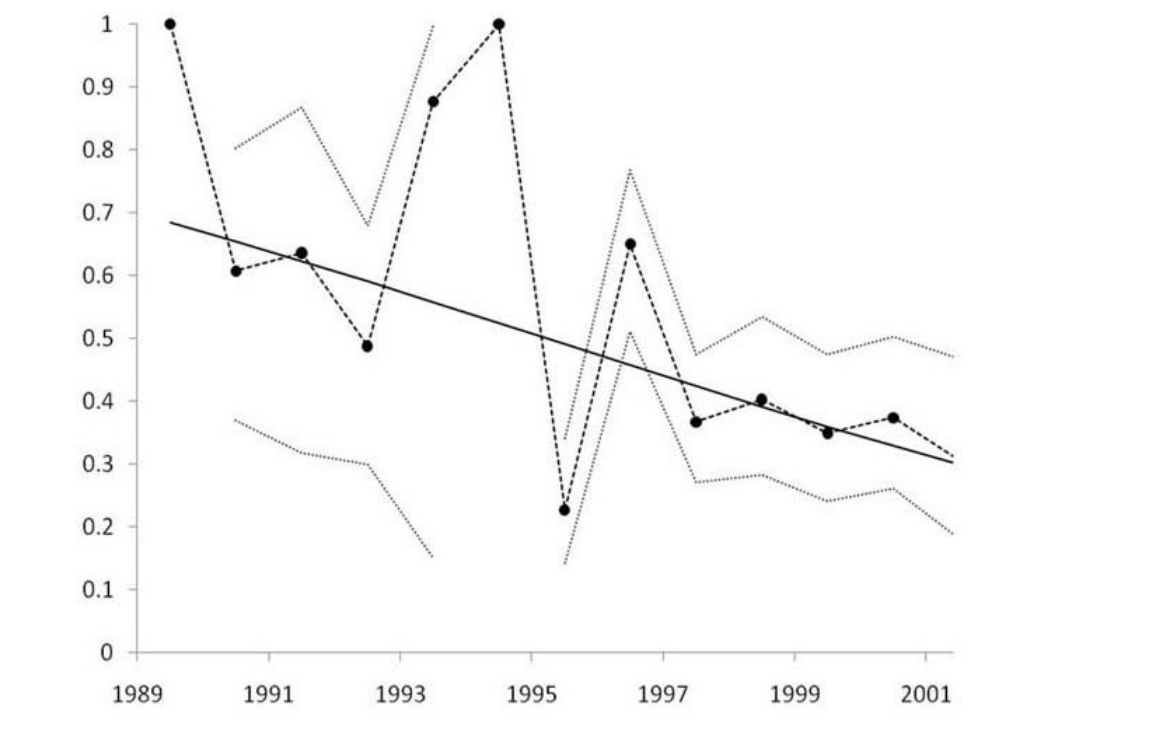
Fig. 6. Apparent survival in the year after banding for Ancient Murrelets ( Synthliboramphus antiquus ) breeding at East Limestone Island (dotted lines represent 95% confidence). The solid line shows the predicted survival in the year following initial capture based on a model that constrained the relationship between year and survival to be linear (on a logit